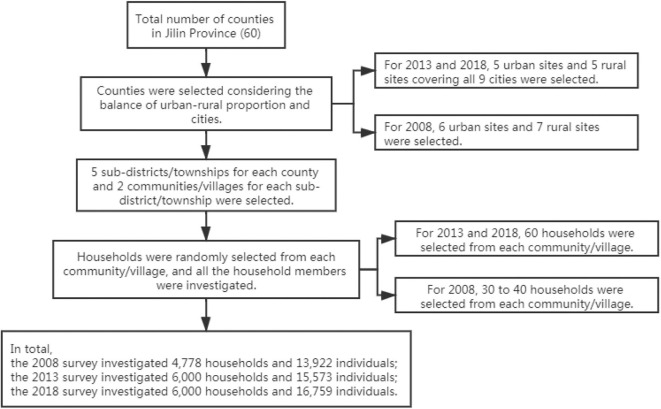
Sampling procedure for NHSS Jilin province.